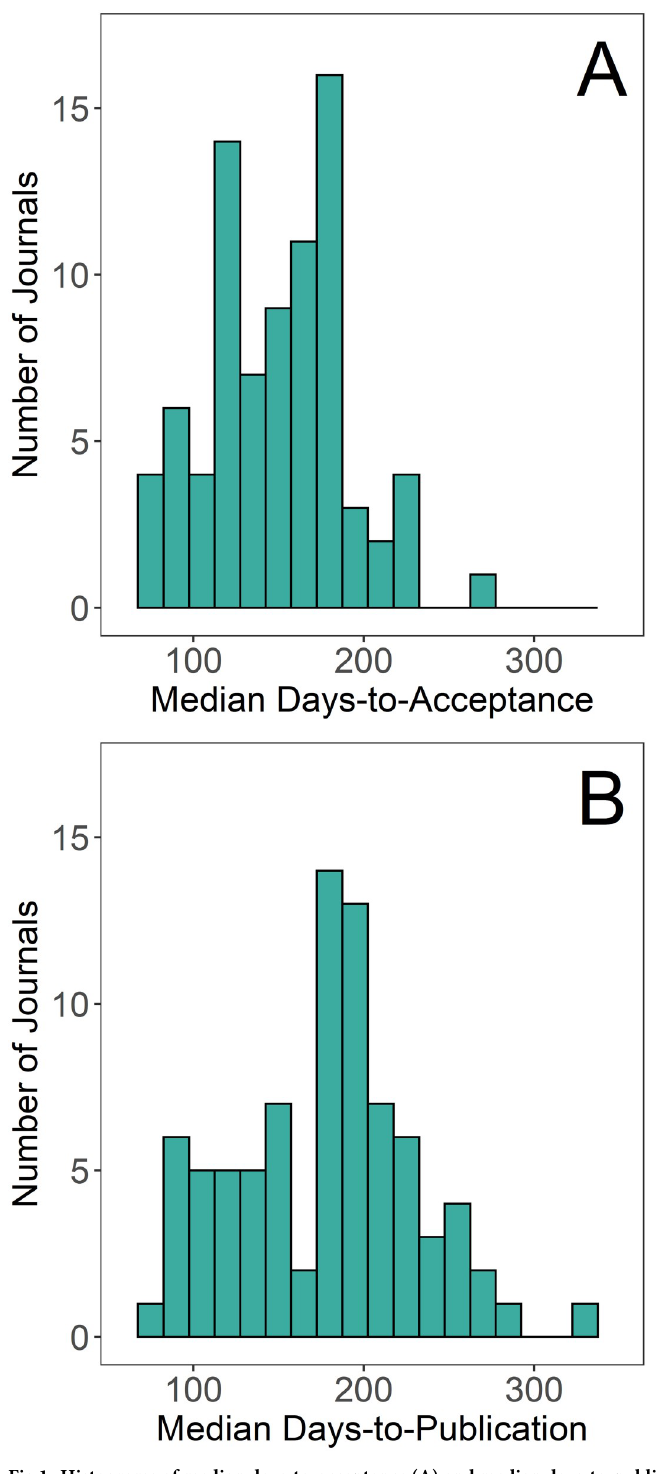
Fig 1. Histograms of median days-to-acceptance (A) and median days-to-publication (B) for 82 journals that publish papers in fisheries and related topics.